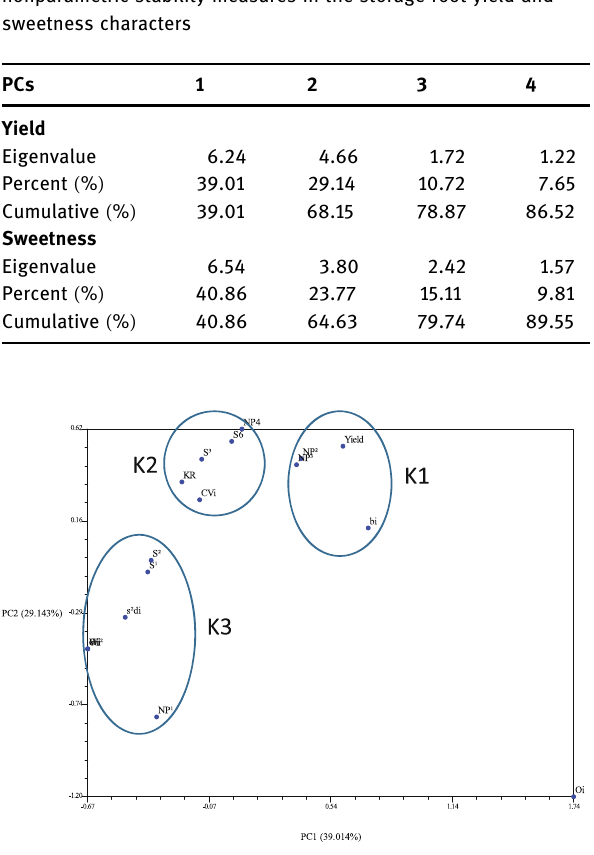
Table 7: PCs, percent, and cumulative values of parametric and nonparametric stability measures in the storage root yield and